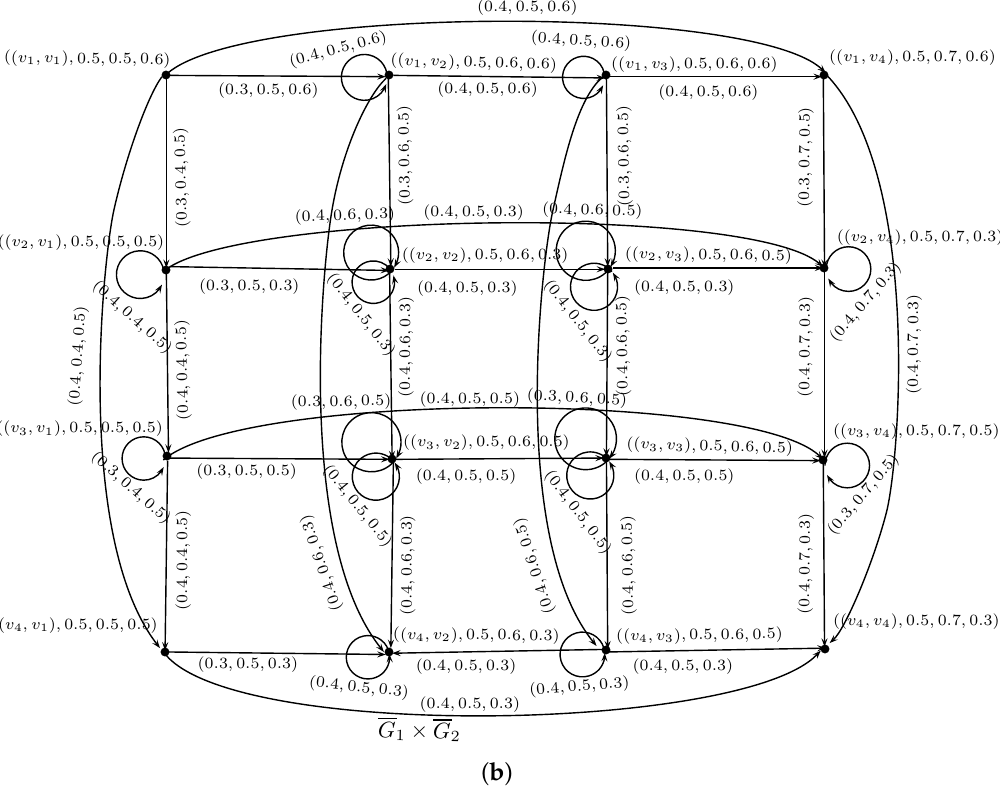
Figure 5: Cartesian product of two neutrosophic soft rough graphs G 1 Figure 5. Cartesian product of two neutrosophic soft rough graphs G 1 ˆ G